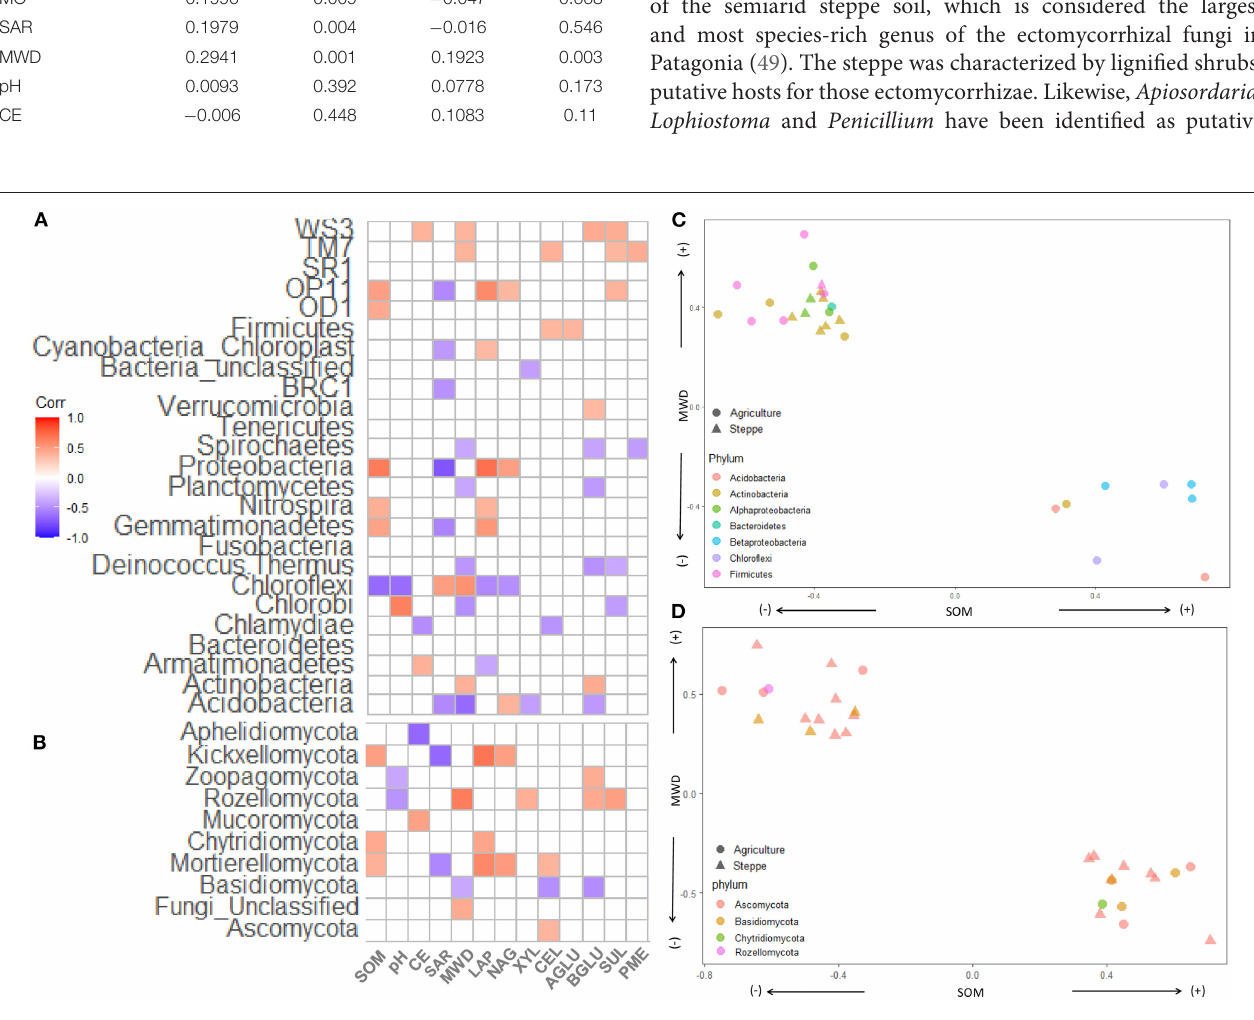
FIGURE 8 | Correlation heatmap of (A) bacterial/archaea and (B) fungal and soil properties. The shade of color indicates the correlation between relative abundance of each microbiota and soil physical and chemical parameters. (C,D) Showing spearman correlation between bacteria/archaea or fungi, respectively, with MWD in the y axis and SOM in the x-axis. SOM, soil organic matter; CE, cation exchange; SAR, sodium absorption ratio; CEL, β -cellobiohydrolase; NAG, N-acetyl- β -glucosaminidase; BGLU, β -glucosidase; AGLU, α -glucosidase; PME, phosphomonoesterase; XYL, XYLanase; LAP, leucine aminopeptidase; SUL,